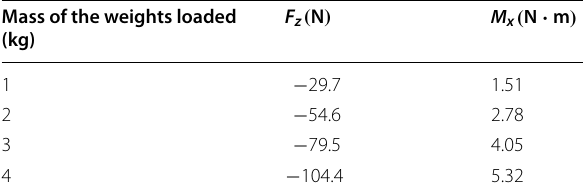
Table 7 The force and moment exerted by the load mechanism Mass of the weights loaded (kg)